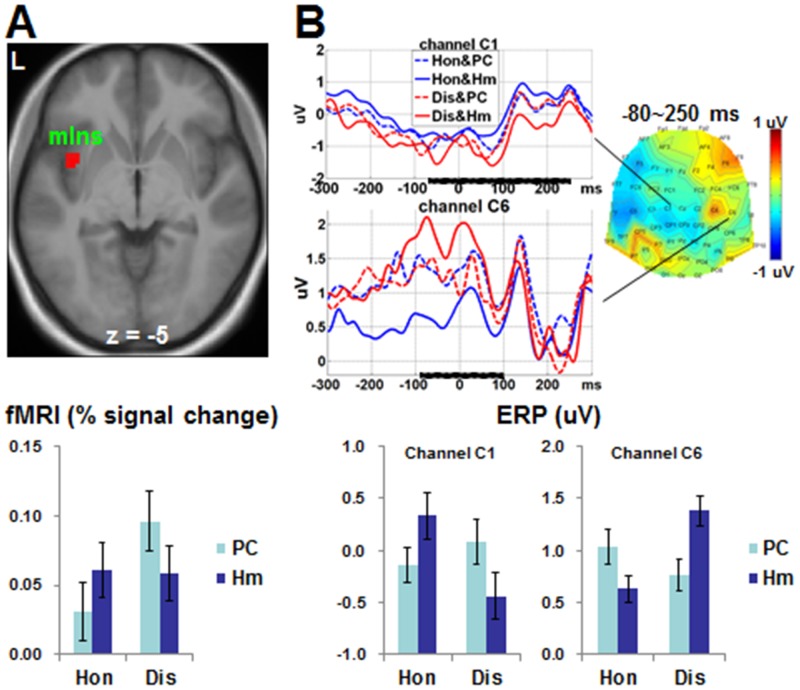
fMRI and ERP findings for interaction between Choice and Investor.(A) In left middle insula, there was a trend that human versus computer counterpart was associated with increased activations when making honest choices, and human versus computer counterpart was related with decreased activations when playing dishonestly. (B) Within the time window of -80~250 ms time-locked to response, human versus computer counterpart was associated with less negative-going amplitudes in channel C1 and less positive-going amplitudes (nonsignificant trend) in channel C6 when honest choices were made. By contrast, human versus computer counterpart was associated with more negative-going amplitudes in channel C1 and more positive-going amplitudes in channel C6 when dishonest choices were made. The SPM T map (for fMRI data) and the scalp topography (for ERP data) represented the contrast of [Hm(Dis-Hon)-PC(Dis-Hon)]. The waveforms in the representative channel are shown for the ERP findings. The horizontal black bars represent the time windows detecting statistical significance. Here, 0 ms indicates the time point of response. Error bar denotes standard error of the mean. L = left.